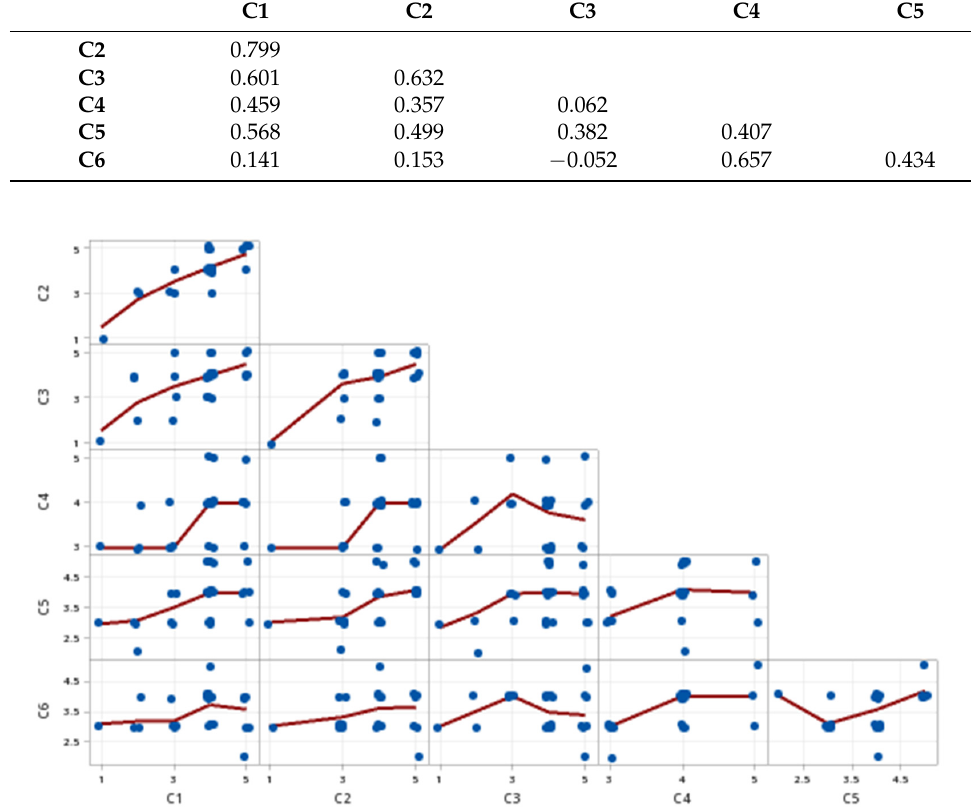
Figure 2. Scattering plot of the six questions